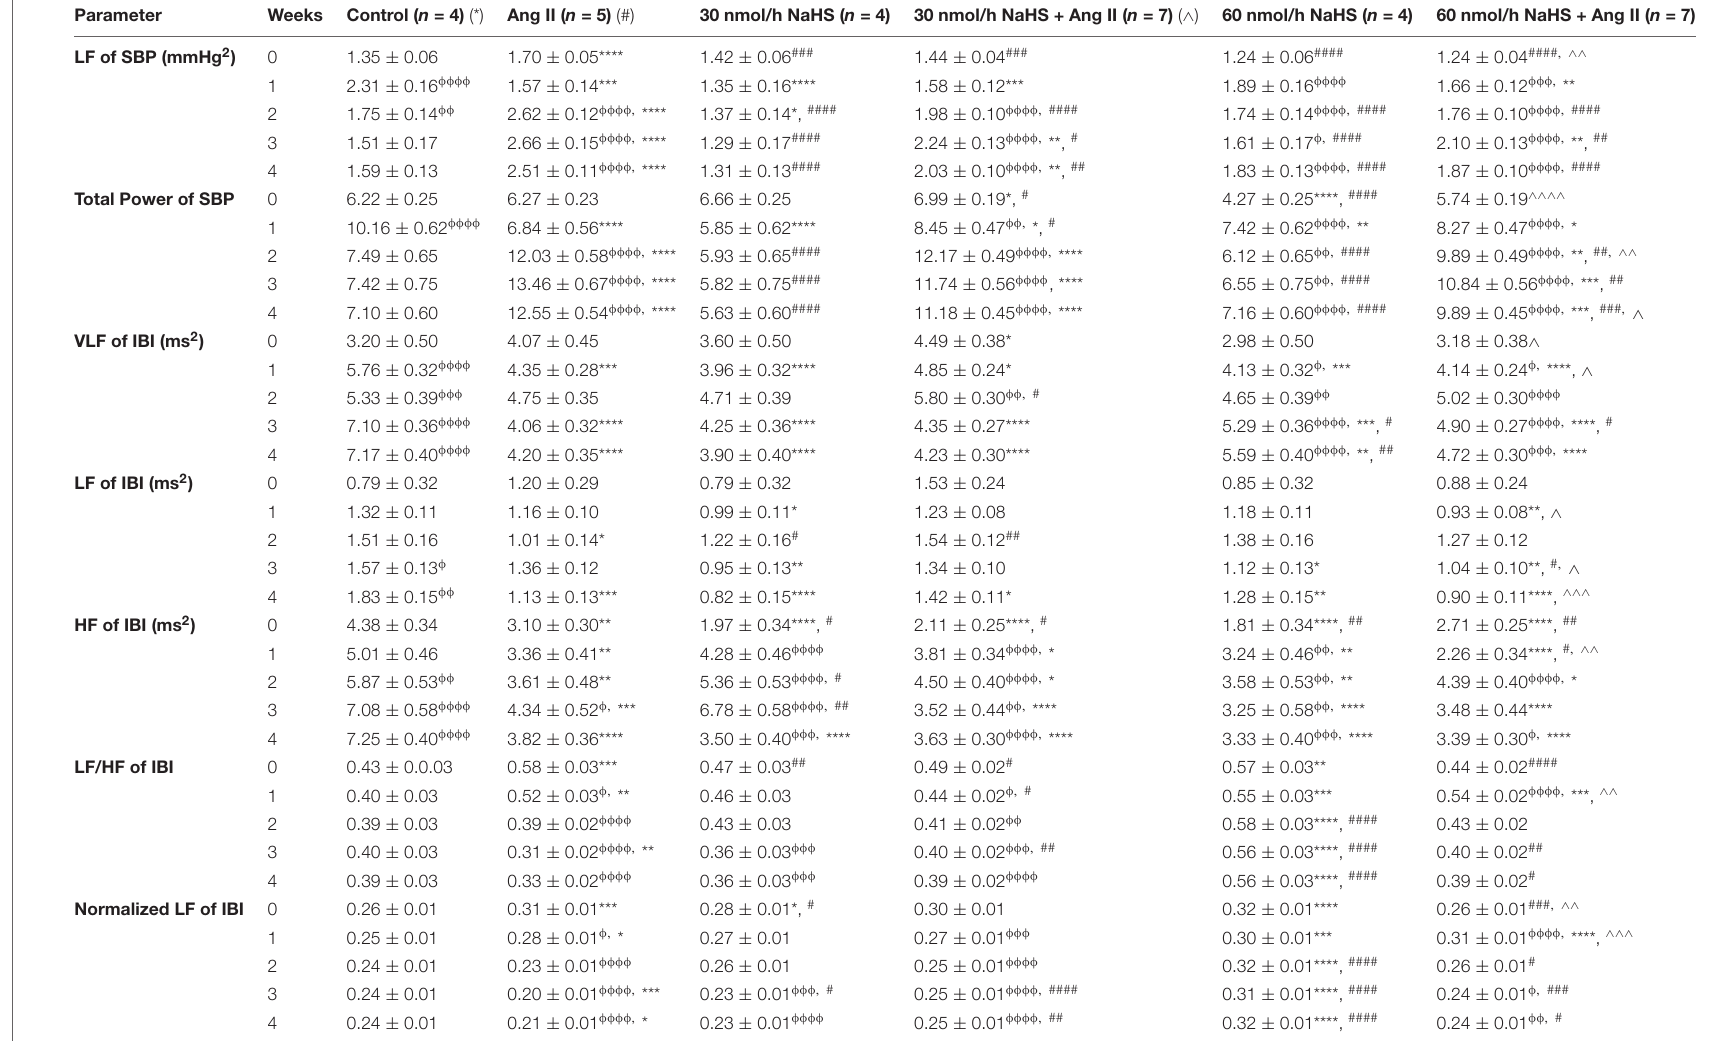
TABLE 2 | Changes in autonomic variables in response to subcutaneous Angiotensin II and intracerebroventricular NaHS infusion.